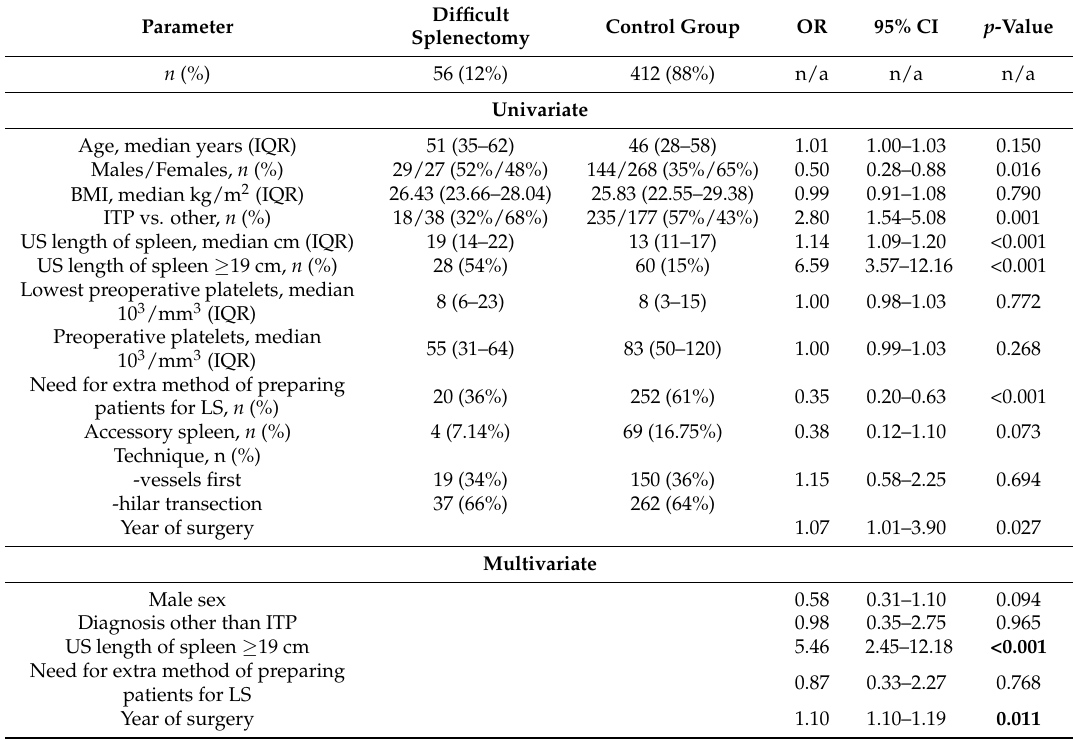
Table 3. Risk factors for difficult splenectomy.